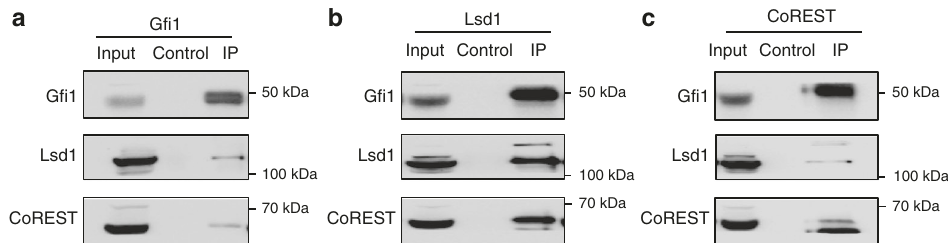
Fig. 2 G fi 1 is associated with Lsd1. a – c Co-immunoprecipitations of a G fi 1, b Lsd1, and c CoREST were performed on MG tumor cells, and G fi 1, Lsd1, and CoREST protein levels were detected by Western blotting. Input represents 10% of total lysate before immunoprecipitation with experimental and isotype control antibodies